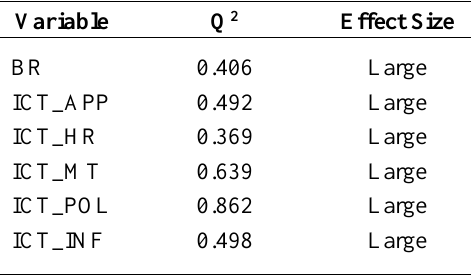
Table 8: Assessment of Predictive Relevance